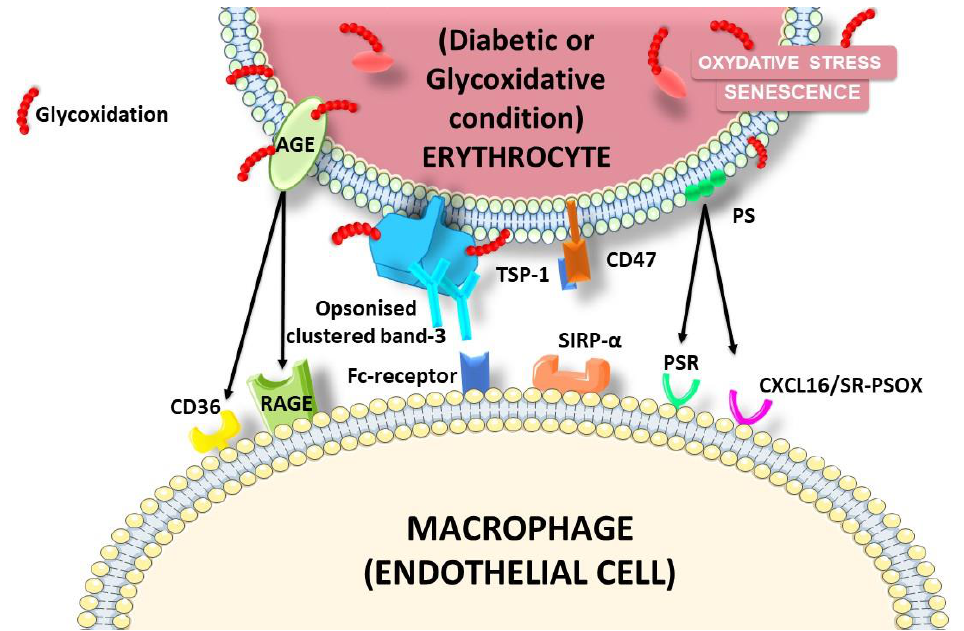
Figure 11. Ligands and receptors involved in glycated erythrocyte interactions with phagocytic cells. Several changes in the erythrocyte membrane are induced by glycation, such as PS exposure, CD47 shift, AGE formation and band.3 clustering. All these changes can be considered as ligands for the recognition and clearance of glycated/damaged erythrocytes.